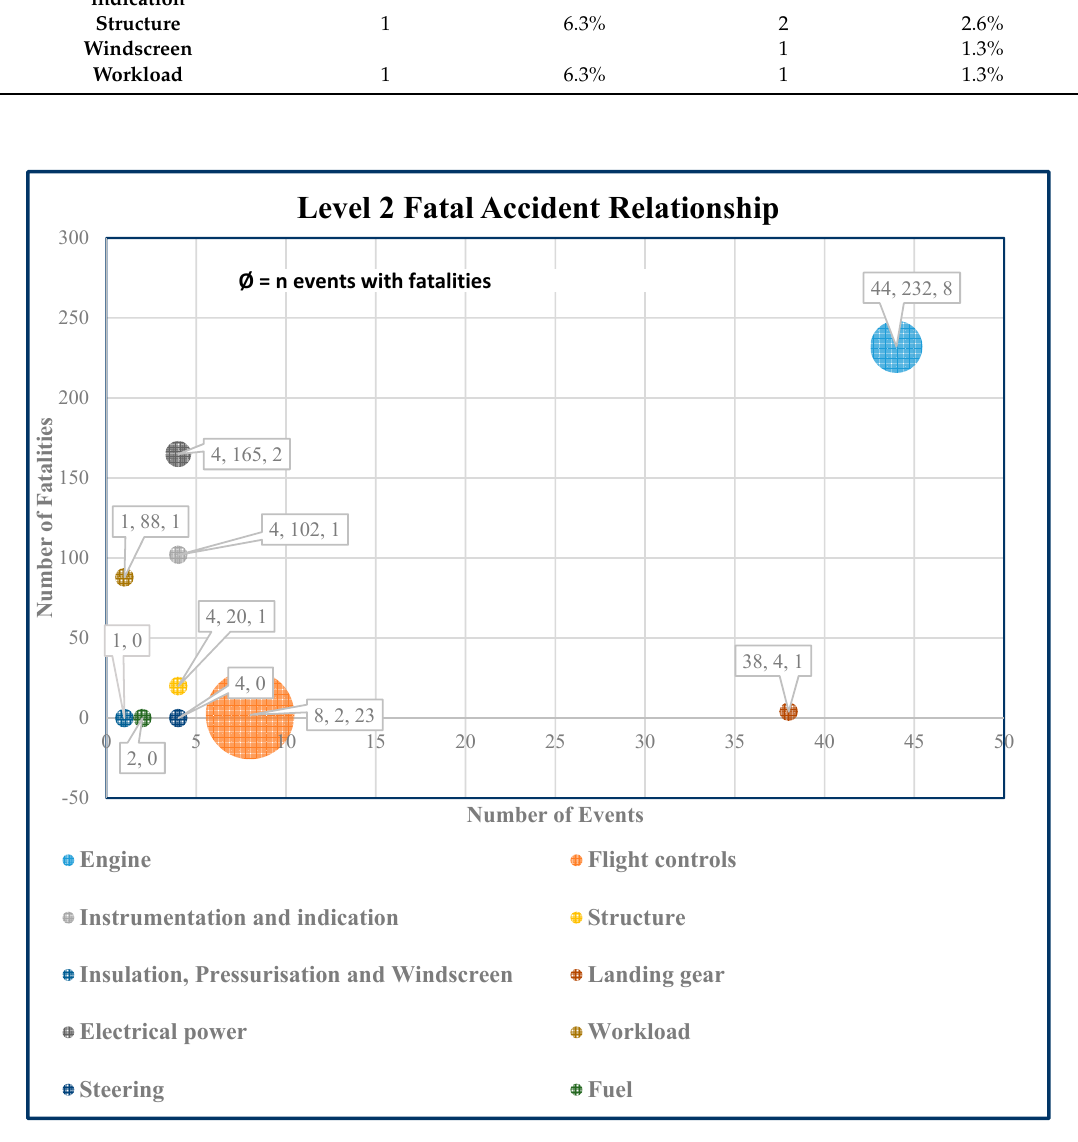
Figure 11. Level 2 fatal accident relationship.